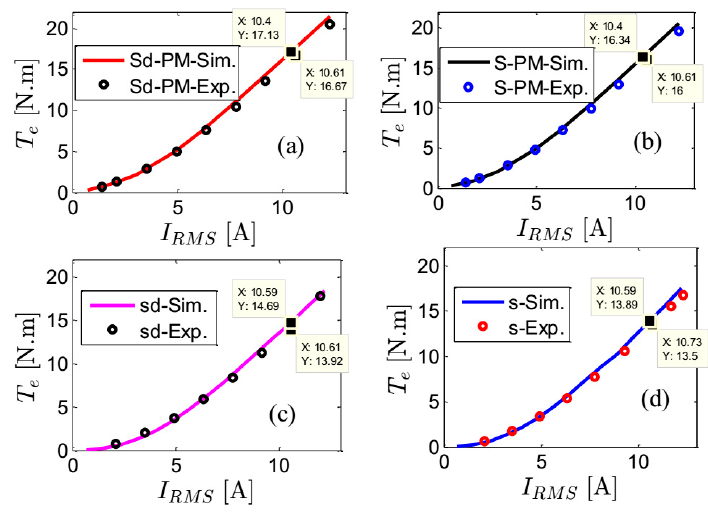
Figure 24. SynRM output torque ( T e ) as a function of stator current ( RMS ) at the optimal current angles